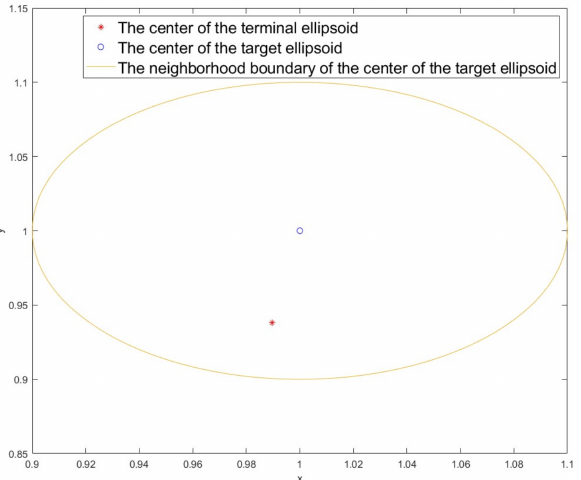
Figure 3. The comparison diagram of the center of the terminal ellipse and the target ellipse without obstacle constraint.